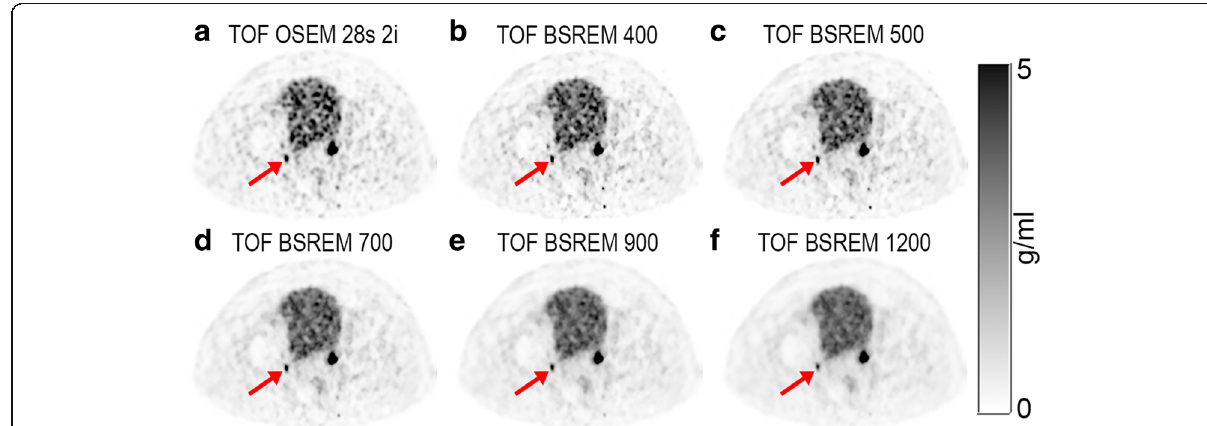
Fig. 5 Example dataset showing axial PET images of the pelvic frame. The reconstructions are TOF OSEM with 28 subsets and 2 iterations ( a ); TOF BSREM with regularization parameter β = 400 ( b ), 500 ( c ), 700 ( d ), 900 ( e ), and 1200 ( f ). All images have SUV scale 0 – 5 g/ml. Red arrow indicates the same lymph node lesion as in Fig. 2. It can be appreciated that the background noise decreases with increasing β values. It can also be appreciated that the SUV of the lymph node lesion decreases with increasing β values; however, the lesion is still clearly detectable even with β = 1200 ( f ). SUV standardized uptake value, TOF time-of-flight, OSEM ordered subset expectation maximization, BSREM block